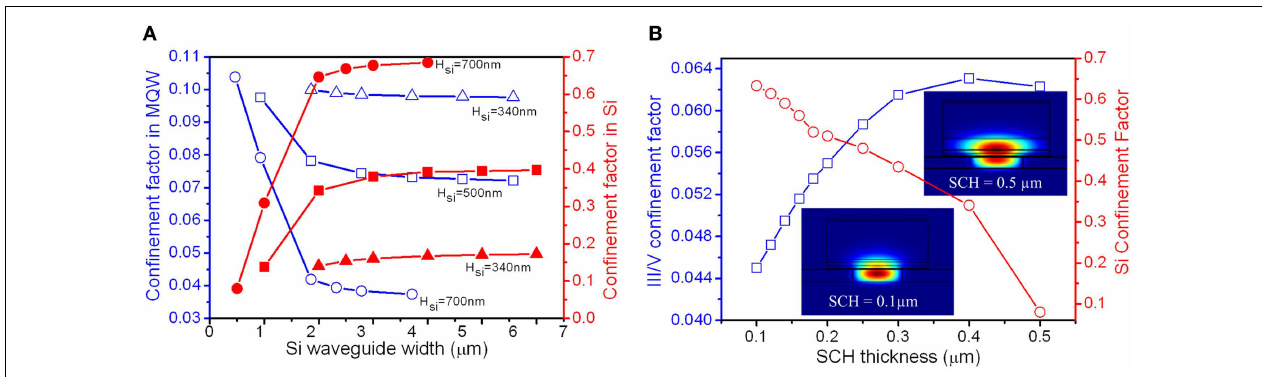
FIGURE 8 | Confinement factor of optical mode in multiple quantum wells (MQW) and Si waveguide as a function of (A) the Si waveguide width under different Si waveguide thicknesses, and (B) the SCH thickness . Insets: the simulated field distributions of the fundamentalTE mode with different SCH thicknesses. It shows that by increasing the thickness of SCH layer up to 500nm, the optical mode is more confined in the III/V active